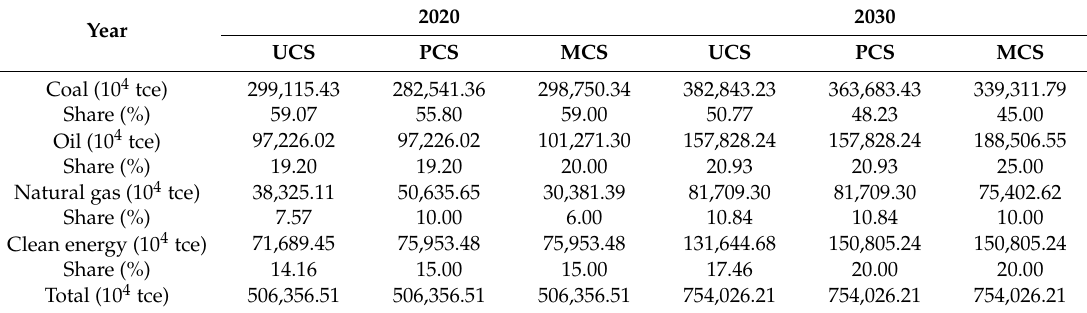
Table 6. China’s primary energy consumption structure forecast